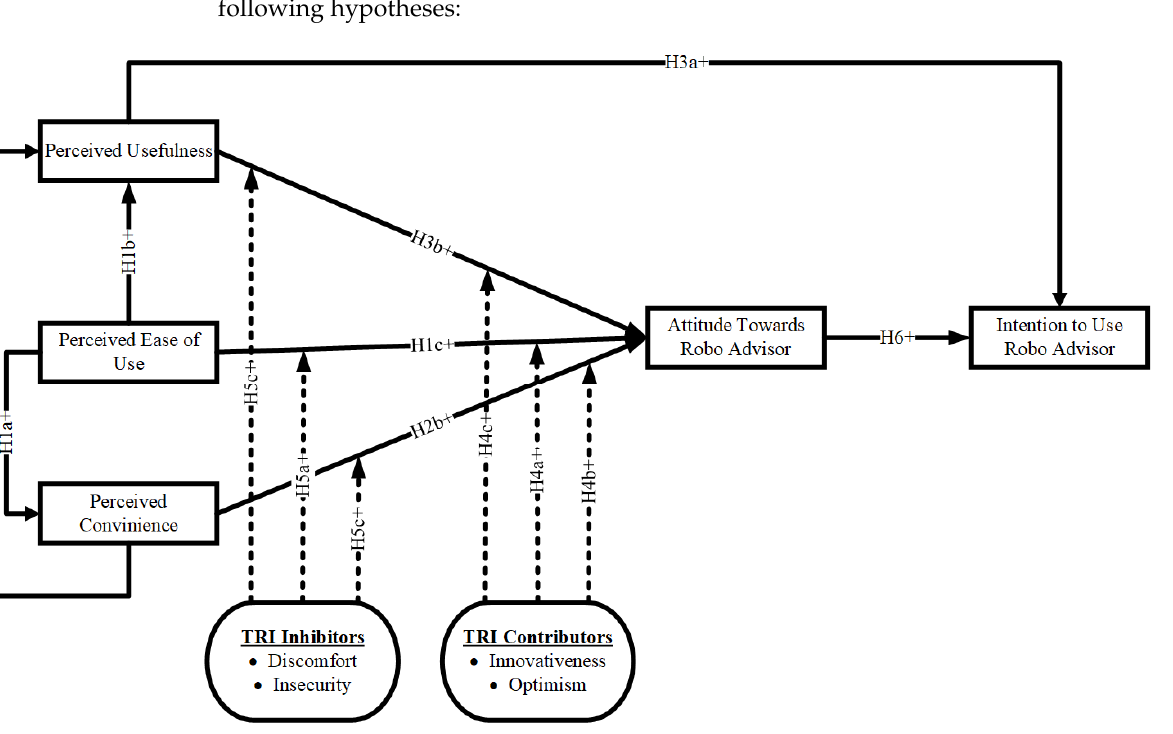
Figure 1. Conceptual framework. Hypothesis 3a. PU positively affects the intention to use Robo-advisors. Hypothesis 3b. PU positively affects